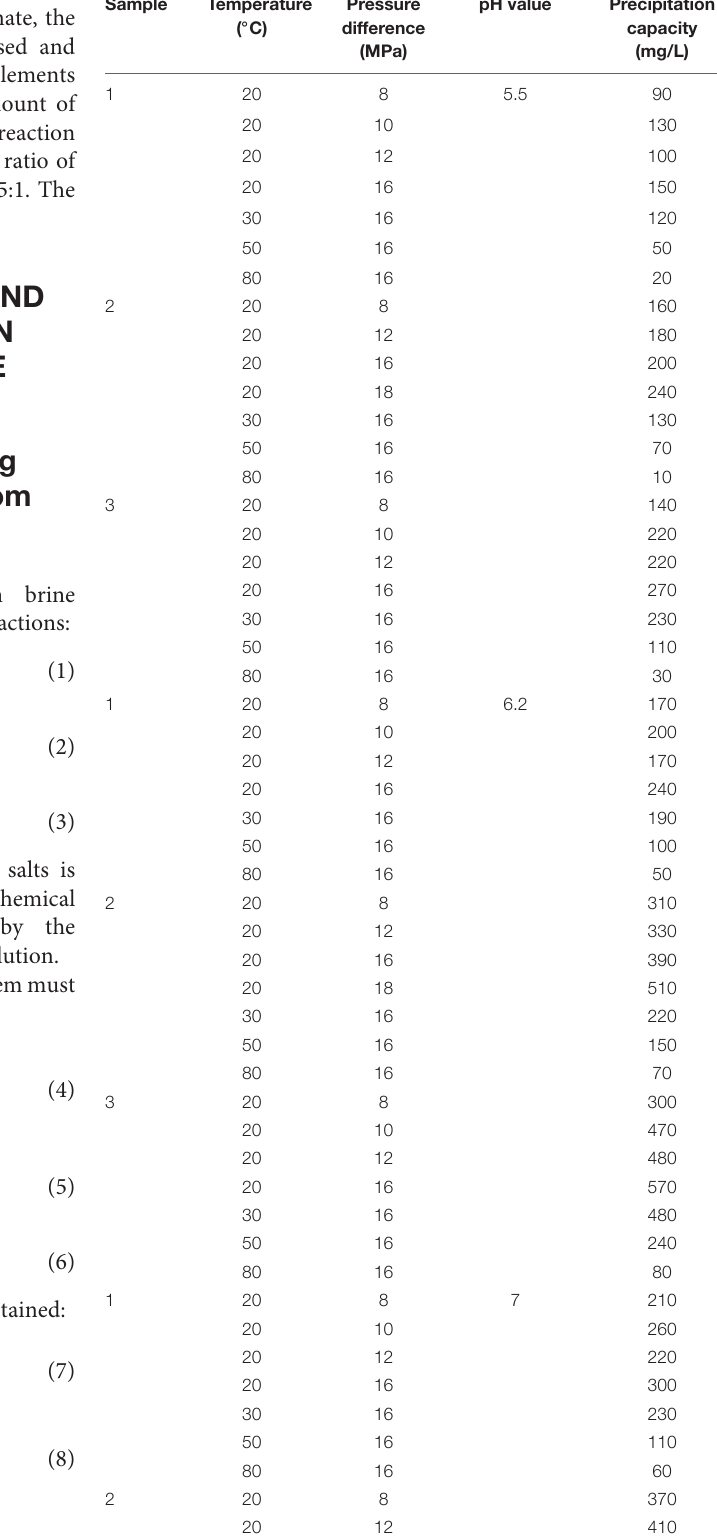
TABLE 2 | The experimental and the simulation results of the precipitation